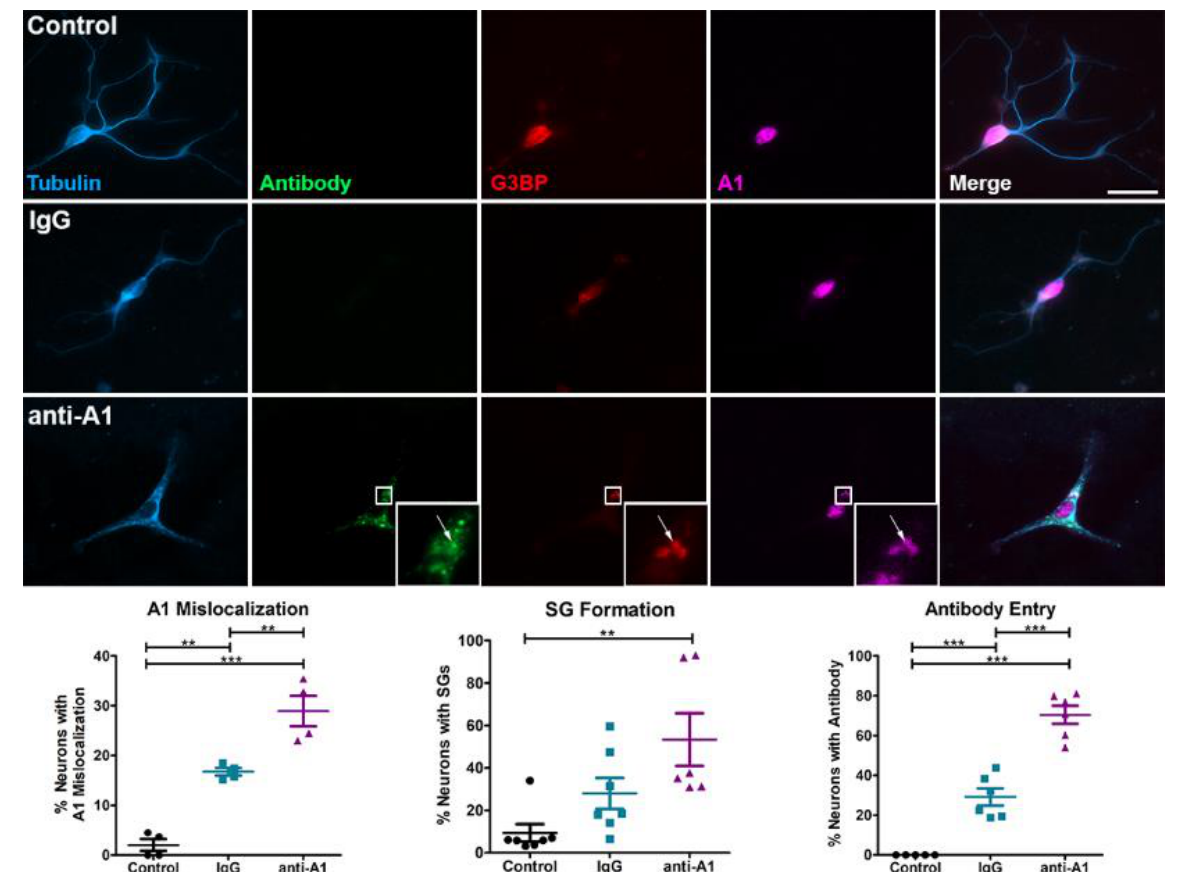
Figure 3. Anti-A1 antibodies enter neurons, leading to A1 mislocalization and SG formation. Primary neurons were treated with anti-A1 antibodies or IgG isotype control antibodies. Anti-A1 antibodies (green) were found to enter neurons at a significantly higher rate than IgG control. Furthermore, neurons treated with anti-A1 antibodies displayed increased A1 mislocalization (magenta) and SG formation (G3BP, red). Arrows indicate colocalization of anti-A1 antibodies, mislocalized A1, and SGs. One-way ANOVA with Tukey’s post hoc tests with ** p < 0.01 *** p < 0.001. Data are plotted as the mean of each replicate +/− SEM. Scale bar 20 μm.